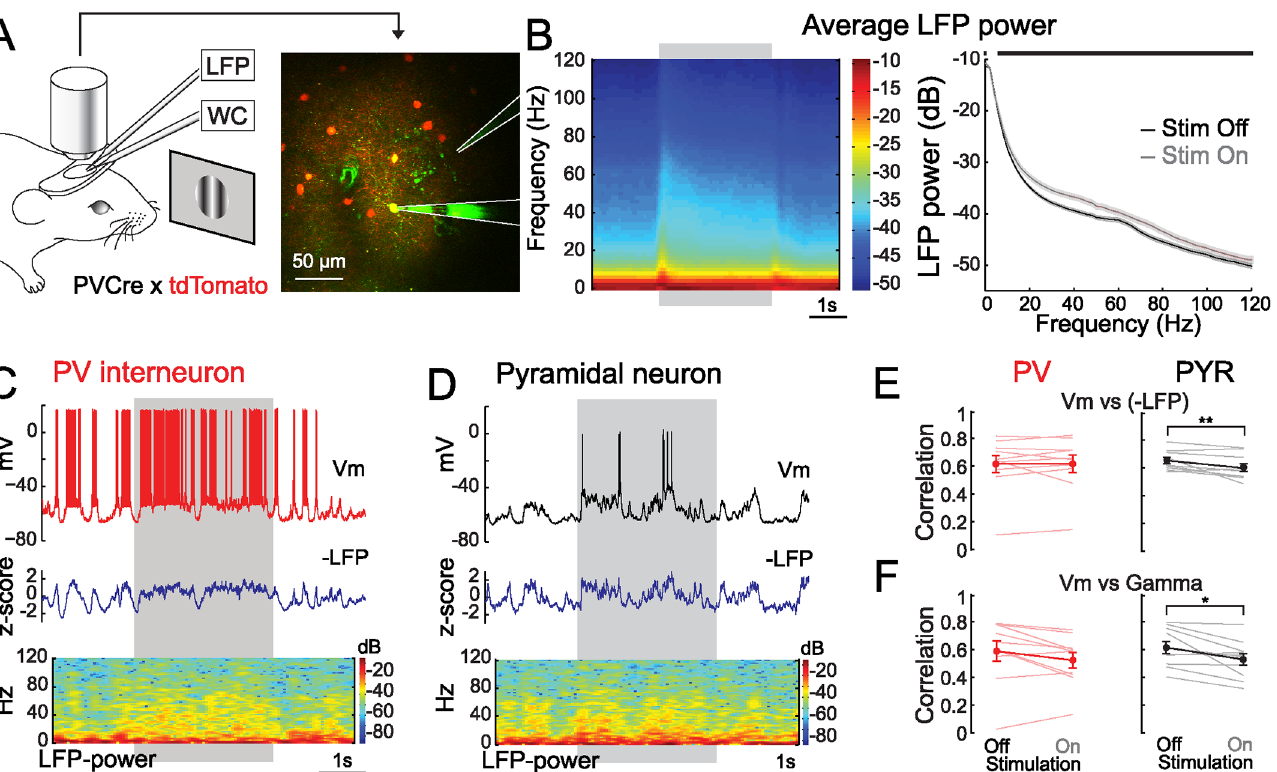
Fig 1. LFP Gamma power correlates with the membrane potential dynamics of PVs and PYRs. ( A ) Experimental design: LFP and two-photon targeted whole-cell (WC) or cell attached recordings of V1 L2/3 PVs and PYRs are performed in awake mice visually stimulated with drifting gratings. Right: micrograph taken during an example PV whole-cell recording. ( B ) Visual stimulation elicits an average increase in LFP power in the beta (12 – 28 Hz) and gamma (30 – 80 Hz) range. Left: grand mean spectro-temporal representation of LFP power around stimulation ( n = 34; grey rectangle: visual stimulation period). Right: average power spectra during (Stim On: grey) and outside (Stim off: black) visual stimulation (shaded areas: +/- standard error of the mean (s. e.m); horizontal black line: statistical significance, False Detection Rate (FDR) corrected signed-rank test, α = 0.05). ( C, D ) Simultaneous LFP and whole-cell recordings of a PV (C) and a PYR (D) (Top: whole-cell recording; Middle: inverted LFP recording; Bottom: spectro-temporal representation of the LFP; grey rectangle: visual stimulation period). ( E ) Vm is correlated with the inverted LFP (-LFP) in PVs ( n = 10) and PYR ( n = 10; thin lines: individual neurons; thick line and filled circles with error bars: mean +/- s.e.m; ** : p < 0.01, signed-rank test). ( F ) Vm is correlated with gamma power in PVs ( n = 10) and PYRs ( n = 10; thin lines: individual neurons; thick line and filled circles with error bars: mean +/- s.e.m; * : p < 0.05, signed-rank test).